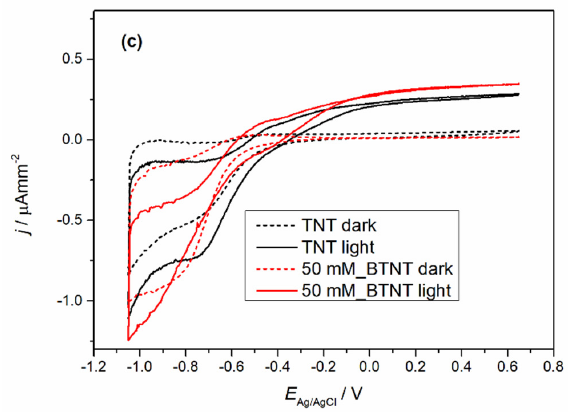
Figure 4. Voltammograms of unmodified TNT and Ba-modified TNT samples: ( a ) 12.5 mM_BTNT, ( b ) 25 mM_BTNT and ( c ) 50 mM_BTNT in dark and light measurements. ( b ) 25 mM_BTNT and ( c ) 50 mM_BTNT in dark and light measurements.